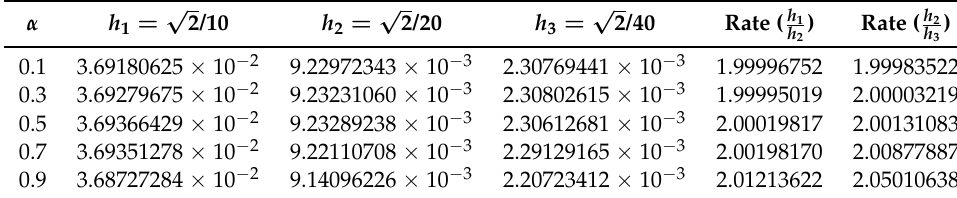
(cid:107) u ( t n ) − u n n